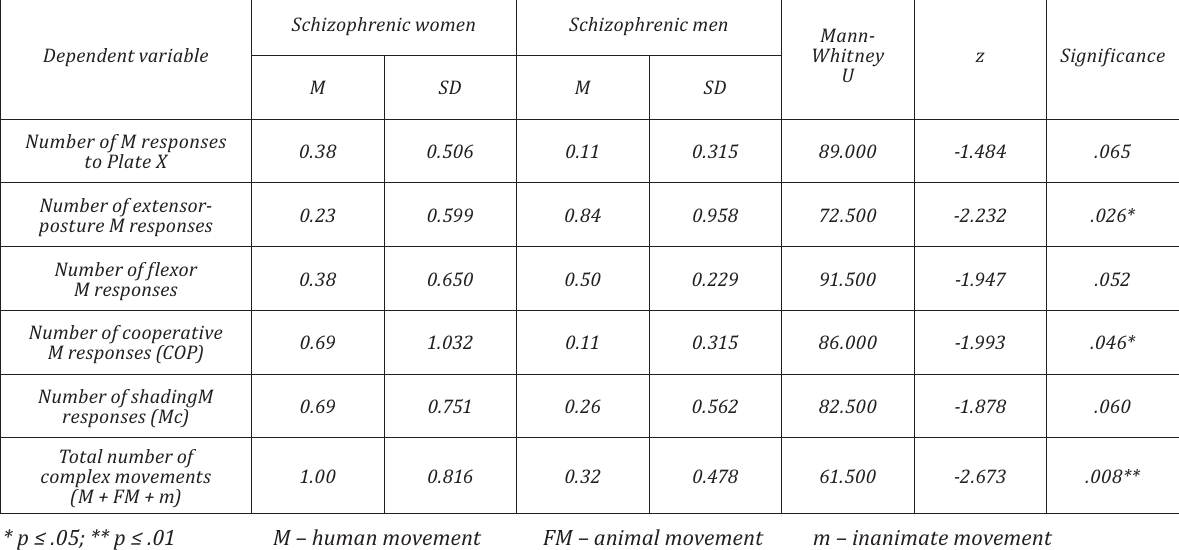
Table 6. Differences and the significance of differences selected variables between the groups of schizophrenic women and schizophrenic